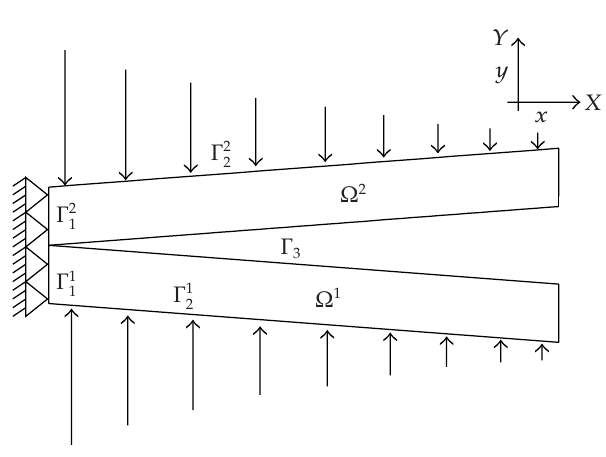
Figure 6.1 . Initial configuration in the first two-dimensional